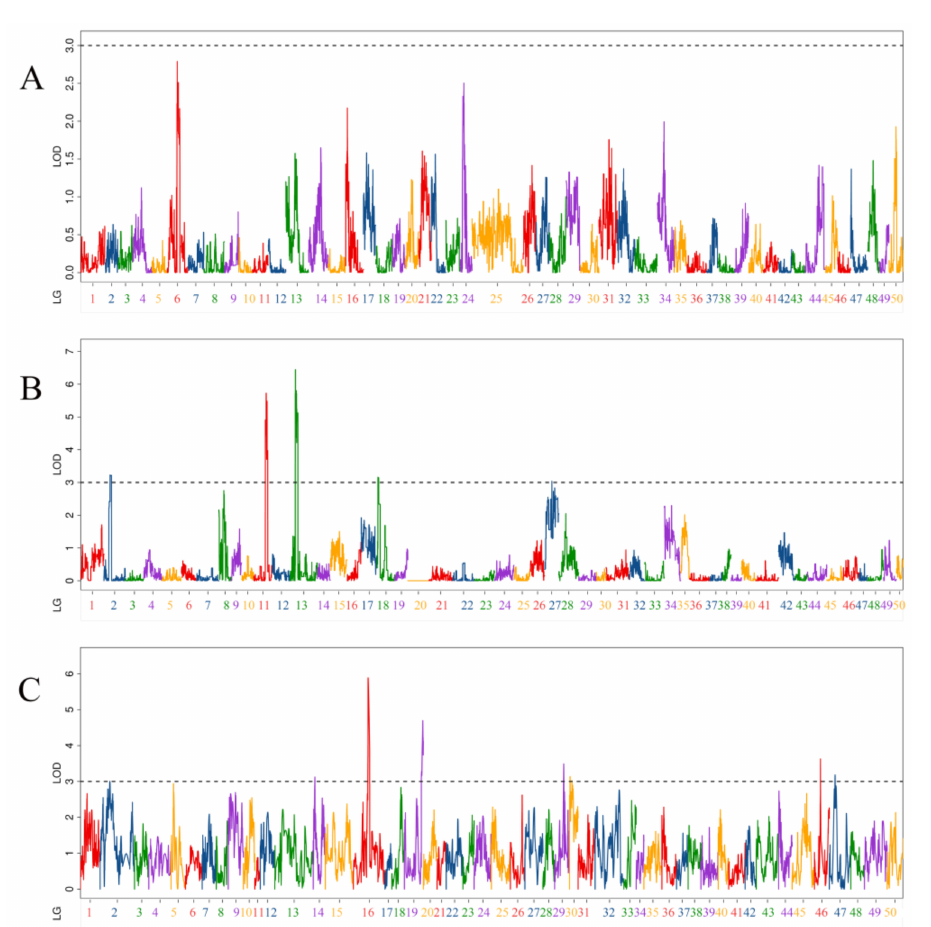
Figure 2. Distribution of body height–related QTL across 50 linkage groups of Yellow River carp from the maternal ( A ), paternal ( B ), and HH maps ( C ).